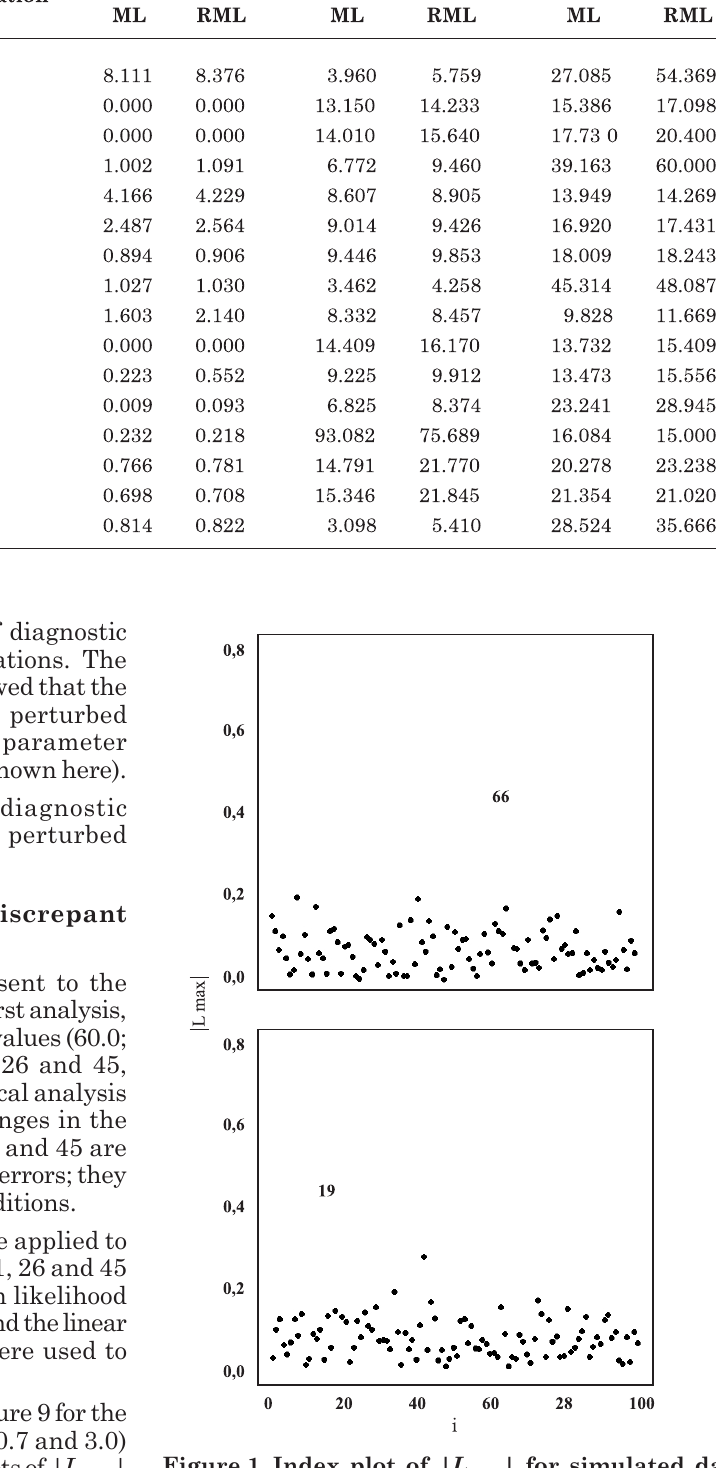
Figure 1. Index plot of |L | for simulated data max using the exponential 0-10-10 (left side) and 0- 10-15 (right side) covariance